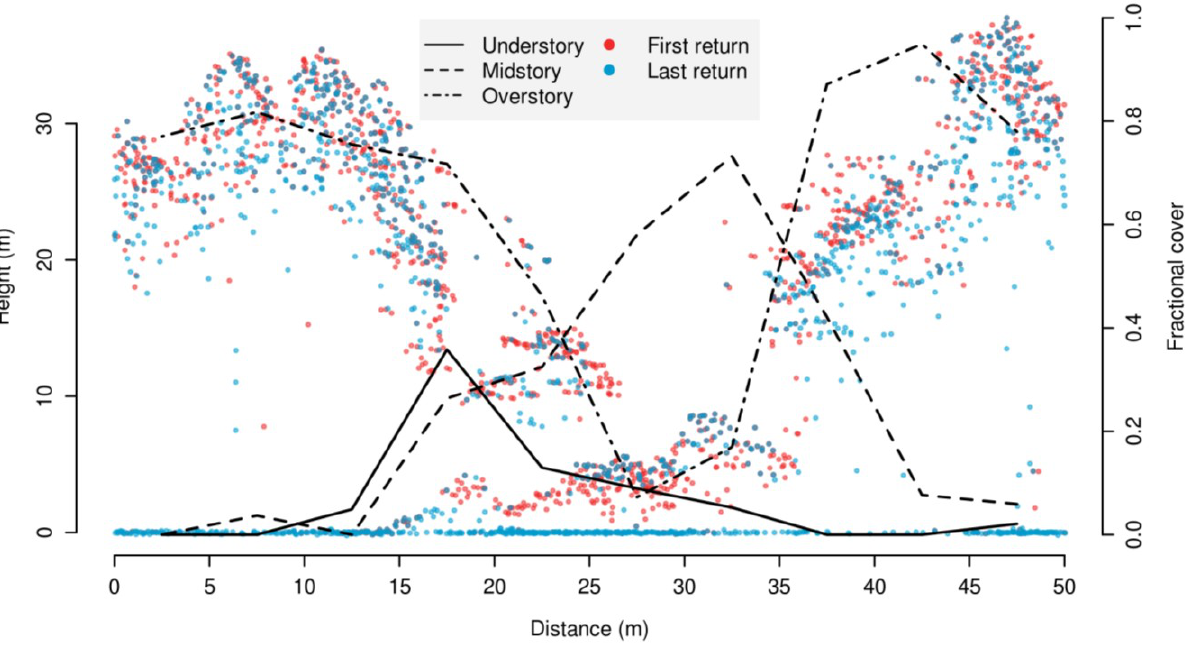
Figure 2. Vertical cross section of LiDAR point cloud data and derived fractional cover values for under-, mid- and overstory along an illustrative 50 m transect of 5 m